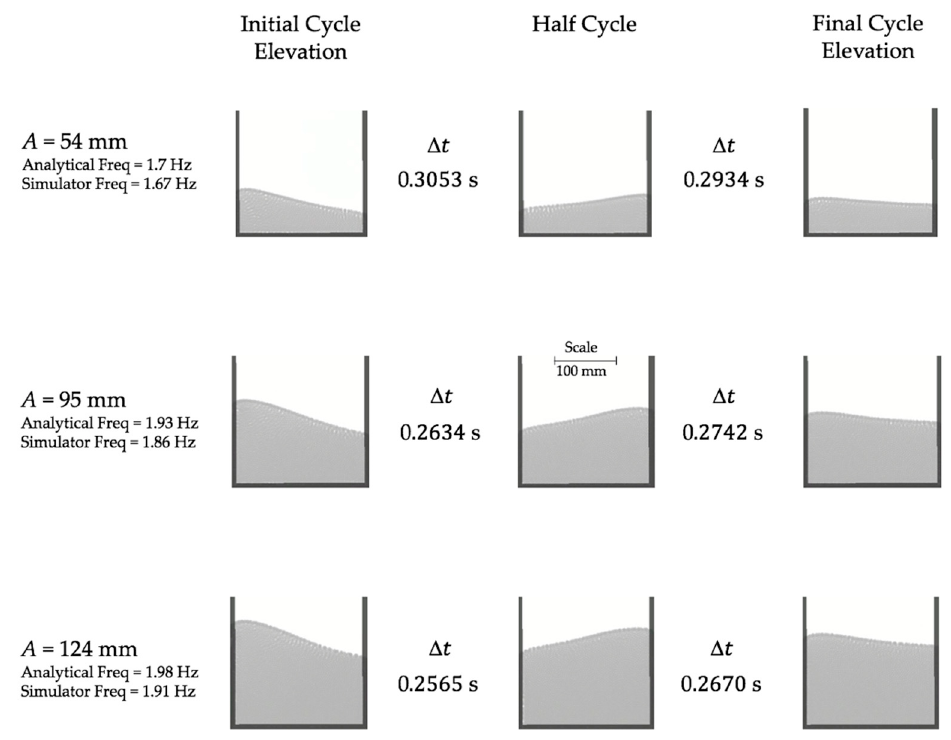
Figure 11. Free surface elevation cycle calibration.